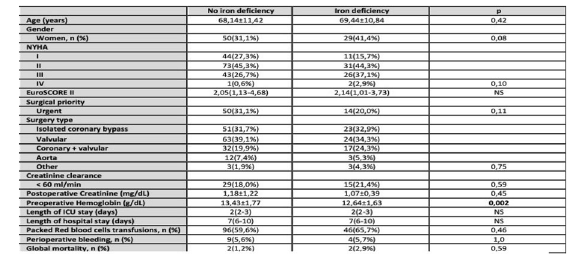
Table 1 (abstract 001459). Baseline characteristics and clinical results